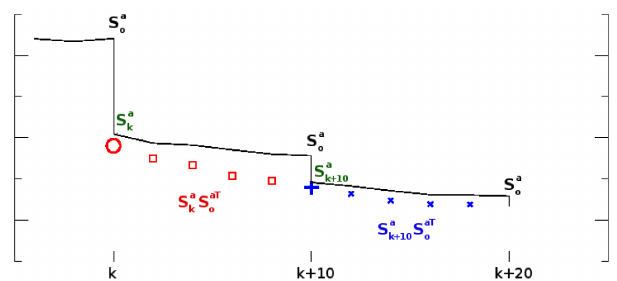
Fig. 9. Schematic representation of the half-fixed basis smoother with a 10-days frequency observations network. Analysis covariance matrix (in green) are computed after each optimal interpolation analysis (at time k and k +10 ). The cross-covariance matrix used for the smoother analysis between date k and k +8 (respectively k +10 and k +20 ) is indicated in red (respectively blue). Smoothed states are indicated with red or blue symbols (see Sect. 6 for more explanations).